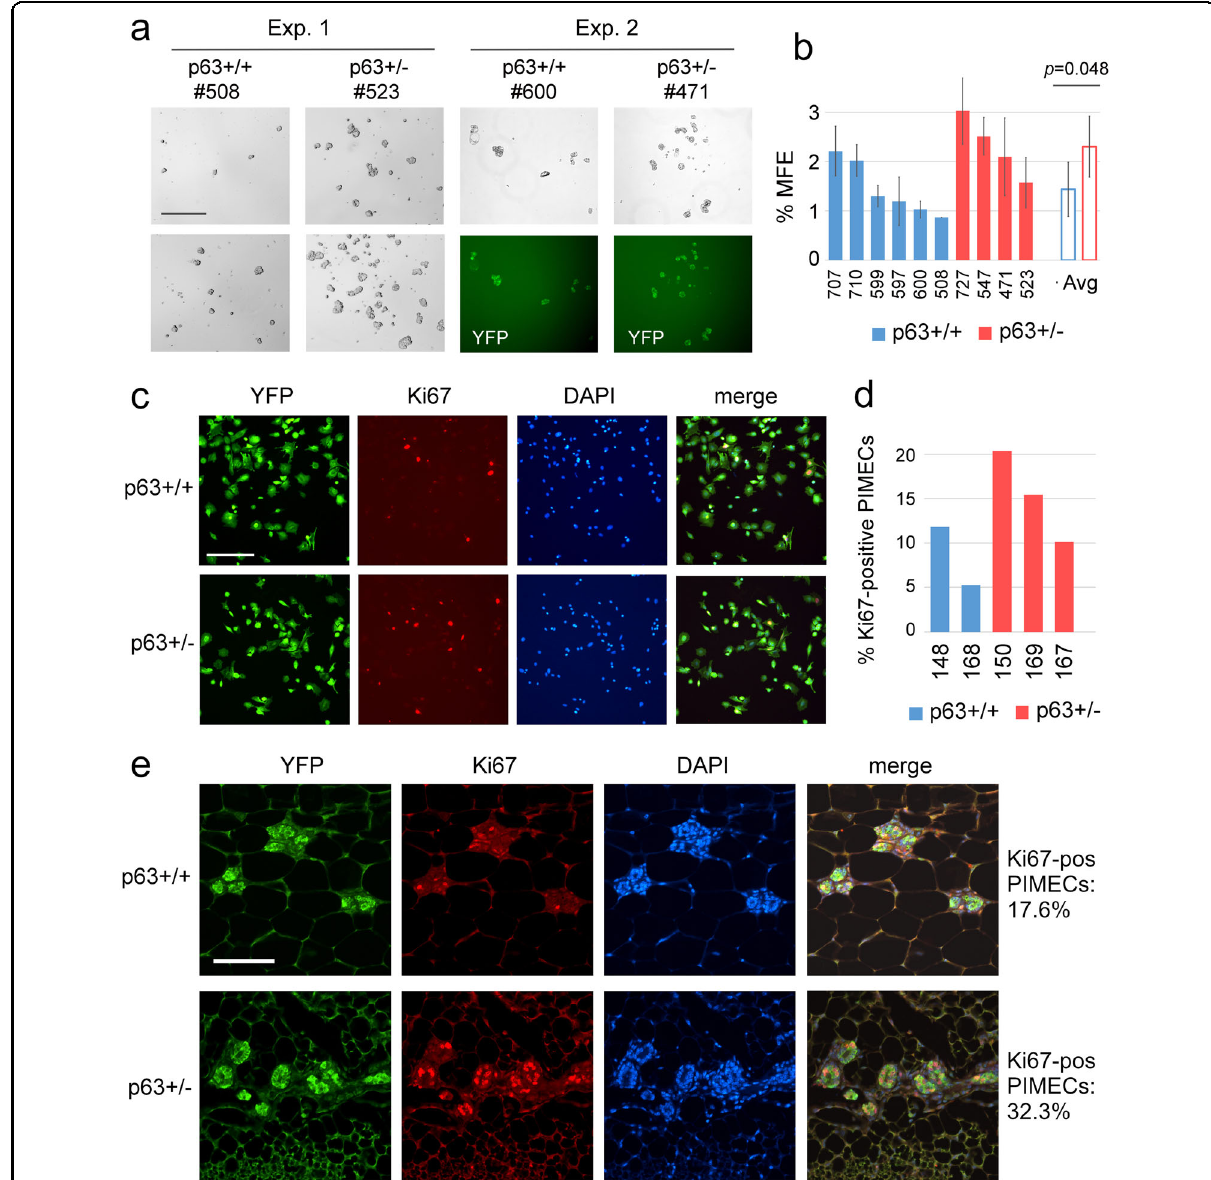
Fig. 2 Increased self-renewal and proliferation of p63 + / − PIMECs. a , b Floating mammosphere assay. a Two representative experiments out of three in total. ~15,000 PIMECs (Exp. 1, two different fi elds are shown) and ~10,000 PIMECs (Exp. 2) were seeded in 12-well plates and analyzed 12 days later. YFP, PIMECs auto- fl uorescence. Scale bar, 250 µm. b Summary of three independent experiments, open bars are mean ± SD of all independent p63 + / + ( n = 6) and p63 + / − ( n = 4) PIMEC isolates, respectively. MFE, mammosphere formation ef fi ciency. See Supplementary Table 1 for more details. c , d PIMECs proliferation in vitro. Freshly FACS-sorted p63 + / + ( n = 2) and p63 + / − ( n = 3) PIMECs were plated onto adherent 24-well plates, followed by immuno fl uorescent staining for YFP (i.e., PIMECs) and Ki67. c Representative images; scale bar, 100 µm. d Quanti fi cation. e PIMECs proliferation in vivo. Mammary glands from a single p63 + / + and p63 + / − sister pair were dissected at 6 weeks post-lactation (the complete involution stage) and stained for YFP and Ki67. Representative images; scale bar, 100